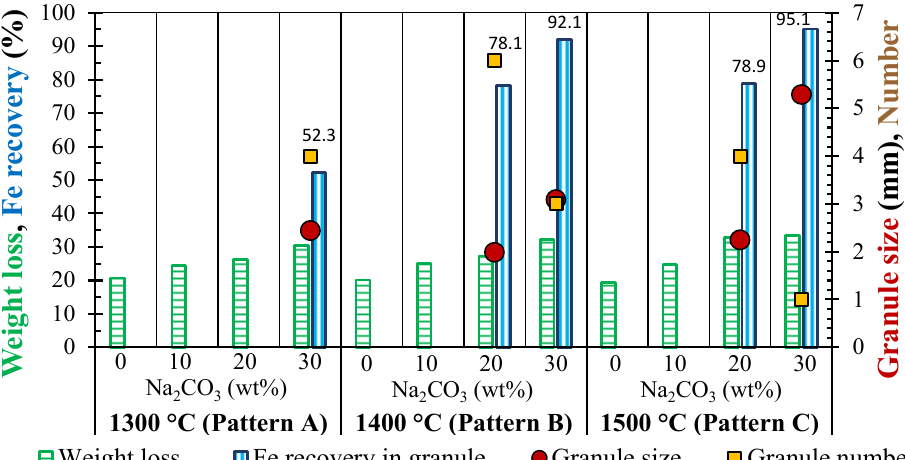
1300 ◦ C (pattern A), although the decreases in weight were observed in all the reduced briquettes with 0 to 30 wt% Na 2 CO 3 addition, the metal granules were only formed at 30% Na 2 CO 3 addition. At the 30% Na 2 CO 3 addition, the weight loss of briquette was 30.4%, the iron recovery in the granules was 52.3% (assuming 96% Fe content in the granules), the average granule size was 2.4 mm, and the number of granules was 4 pieces.